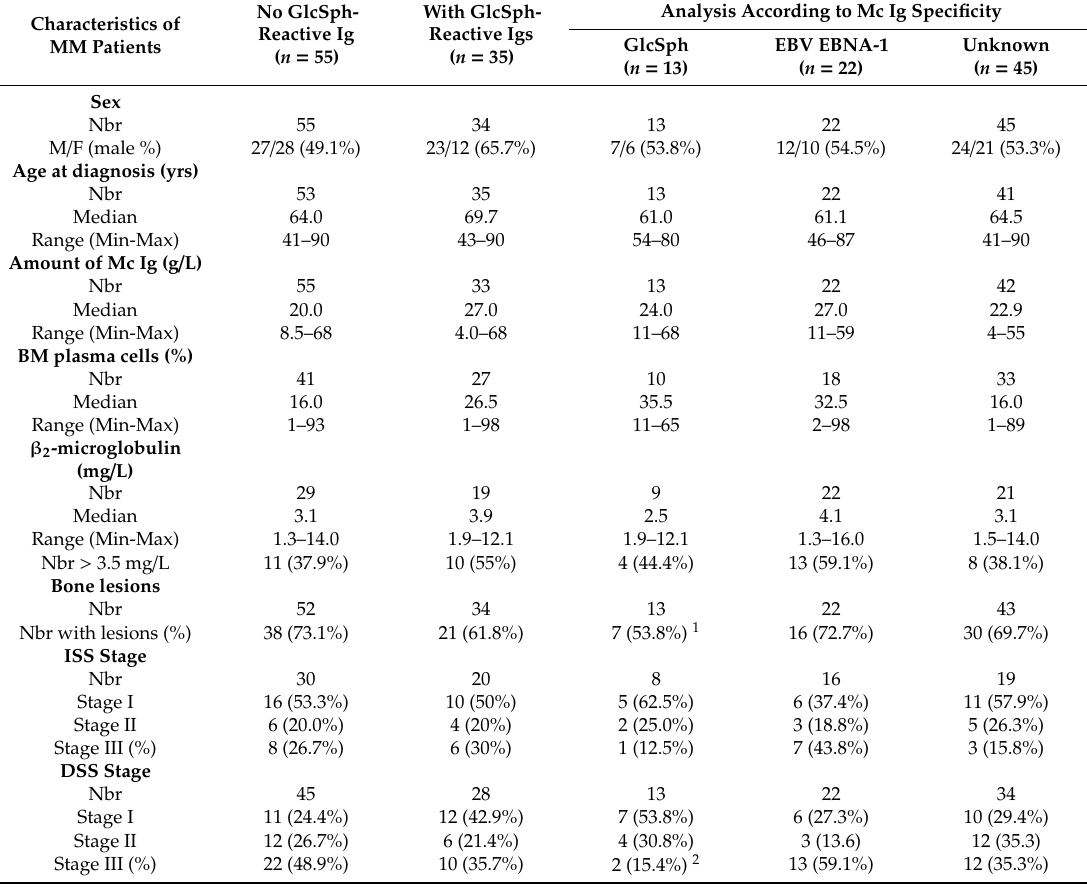
Table 3. Characteristics of MM patients with GlcSph-reactive